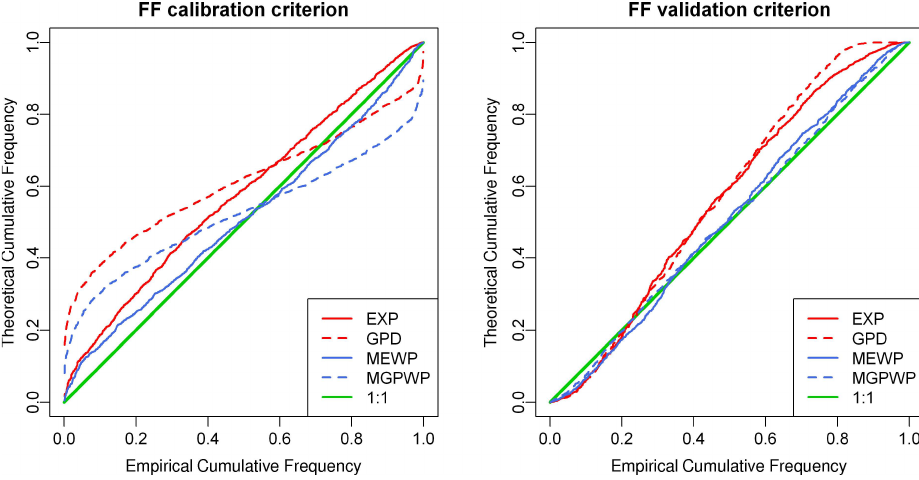
Fig. 6. pp-plot of FF scores in calibration and validation. Whole dataset is used to computed these distributions. Table 3. Results of the reliability procedure for the six probabilistic